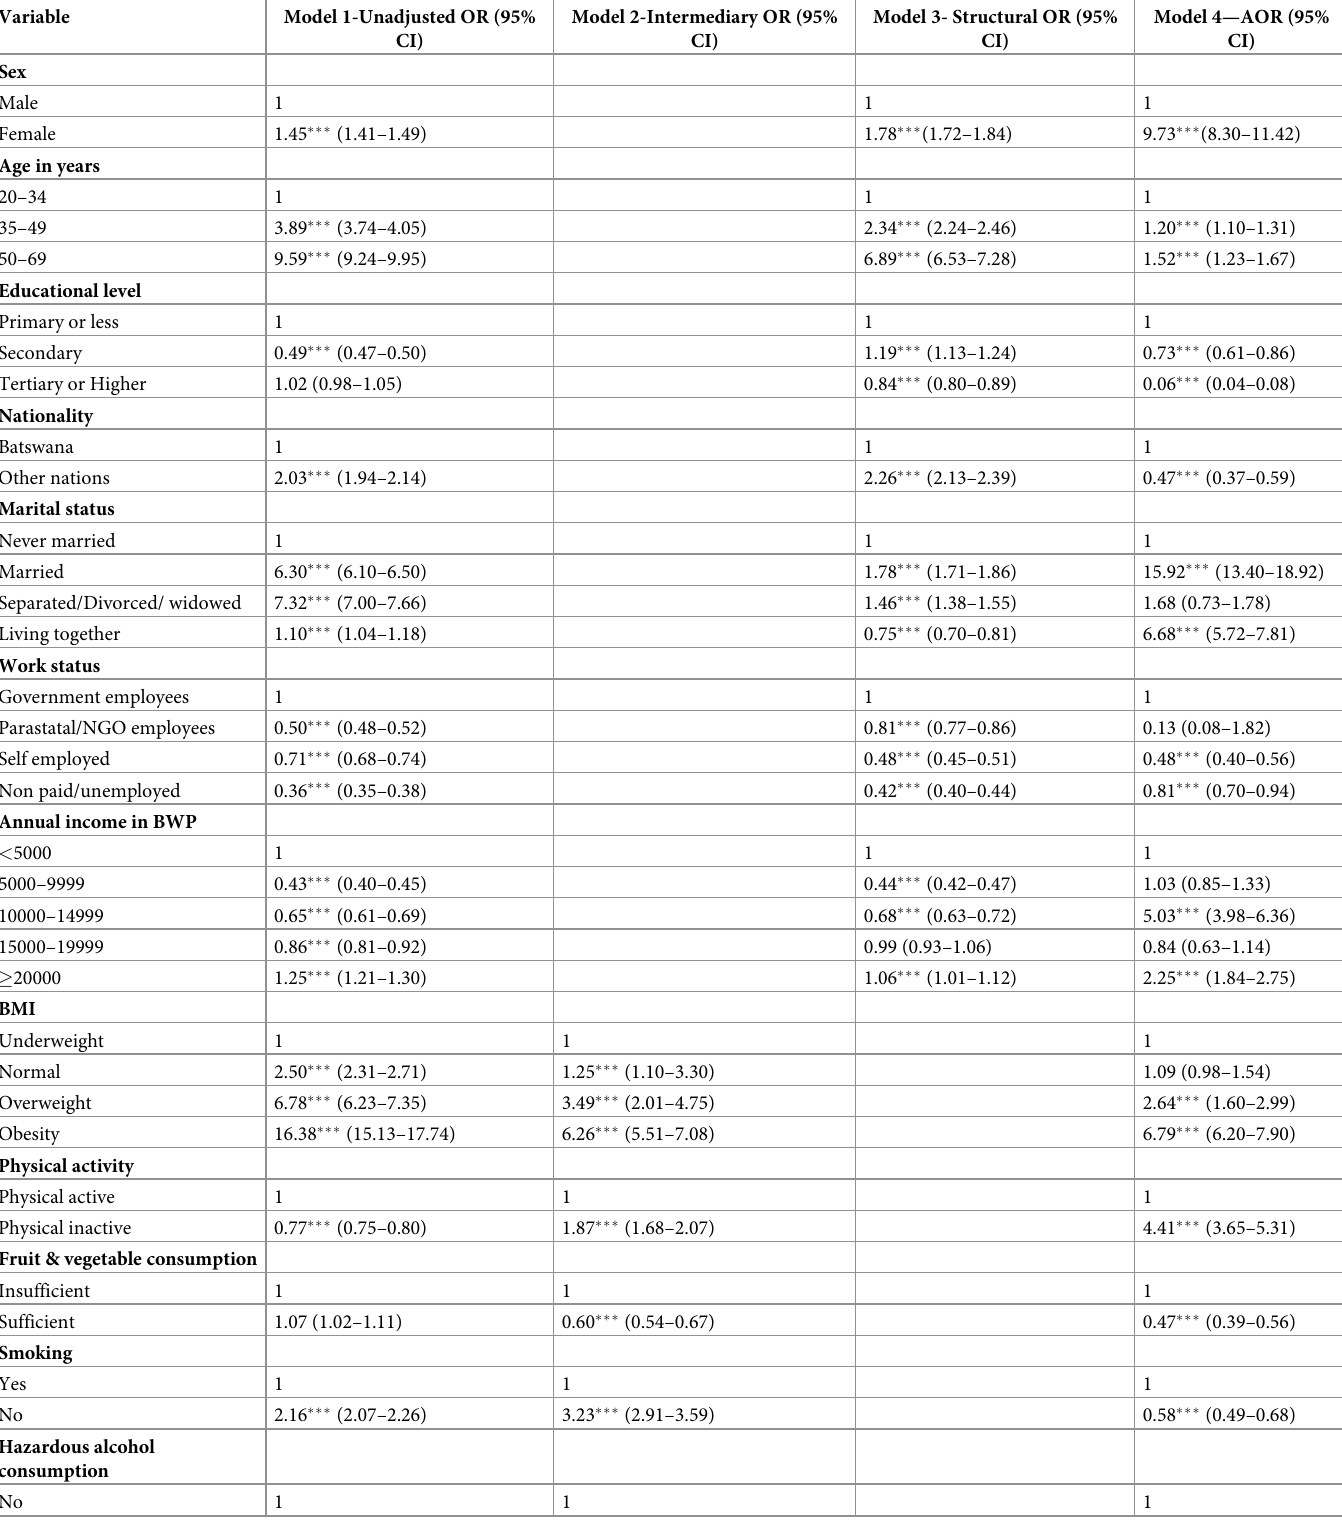
Table 3. Logistic regression analysis results of factors associated with hypertension, diabetes or stroke/heart attack